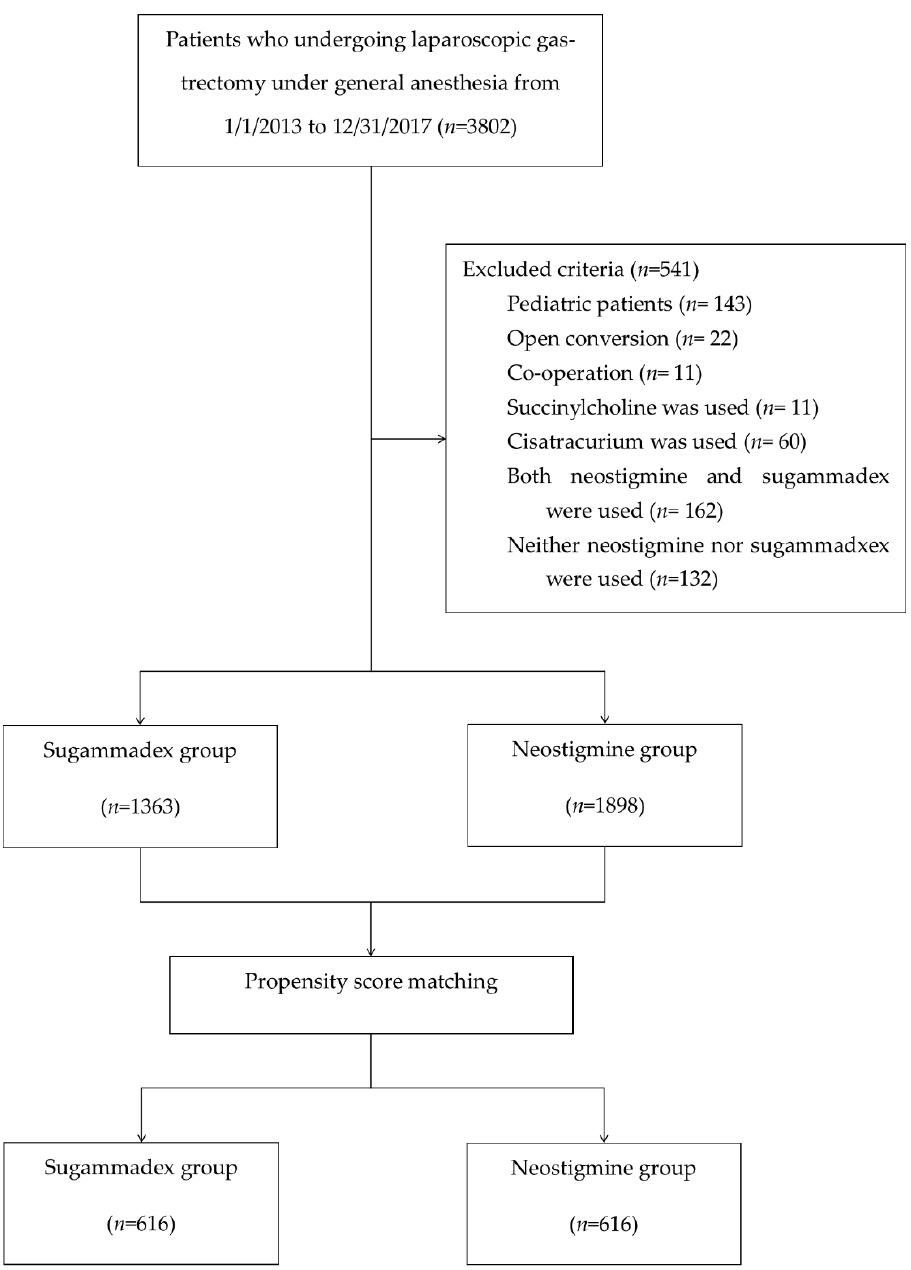
Figure 1. Flow chart of the study population.